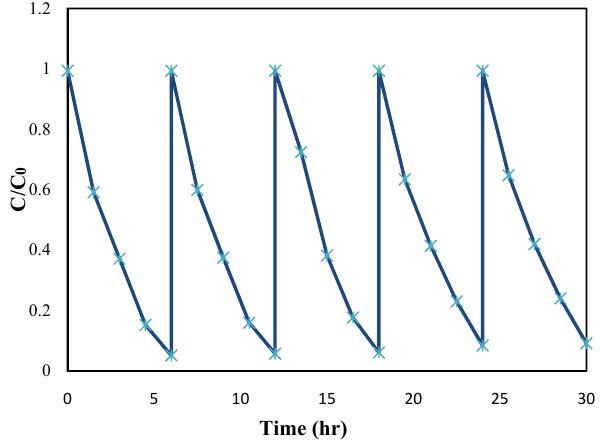
/Fe O /MWCNT in 5 consecutive cycles 2 3 4